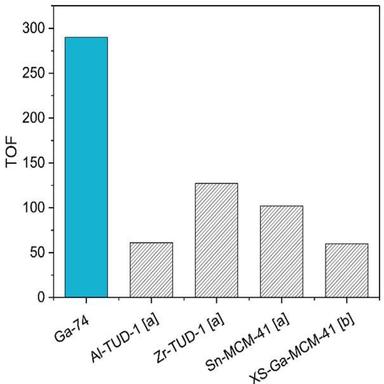
Catalytic activity of Ga-74 in the conversion of glycerol to solketal compared to metal-silicates reported in the literature:,. Reaction conditions: 0.01 mol of glycerol, 1 eq. of acetone, 0.02 mol of t-butanol, 2 h and 25 mg of catalyst.